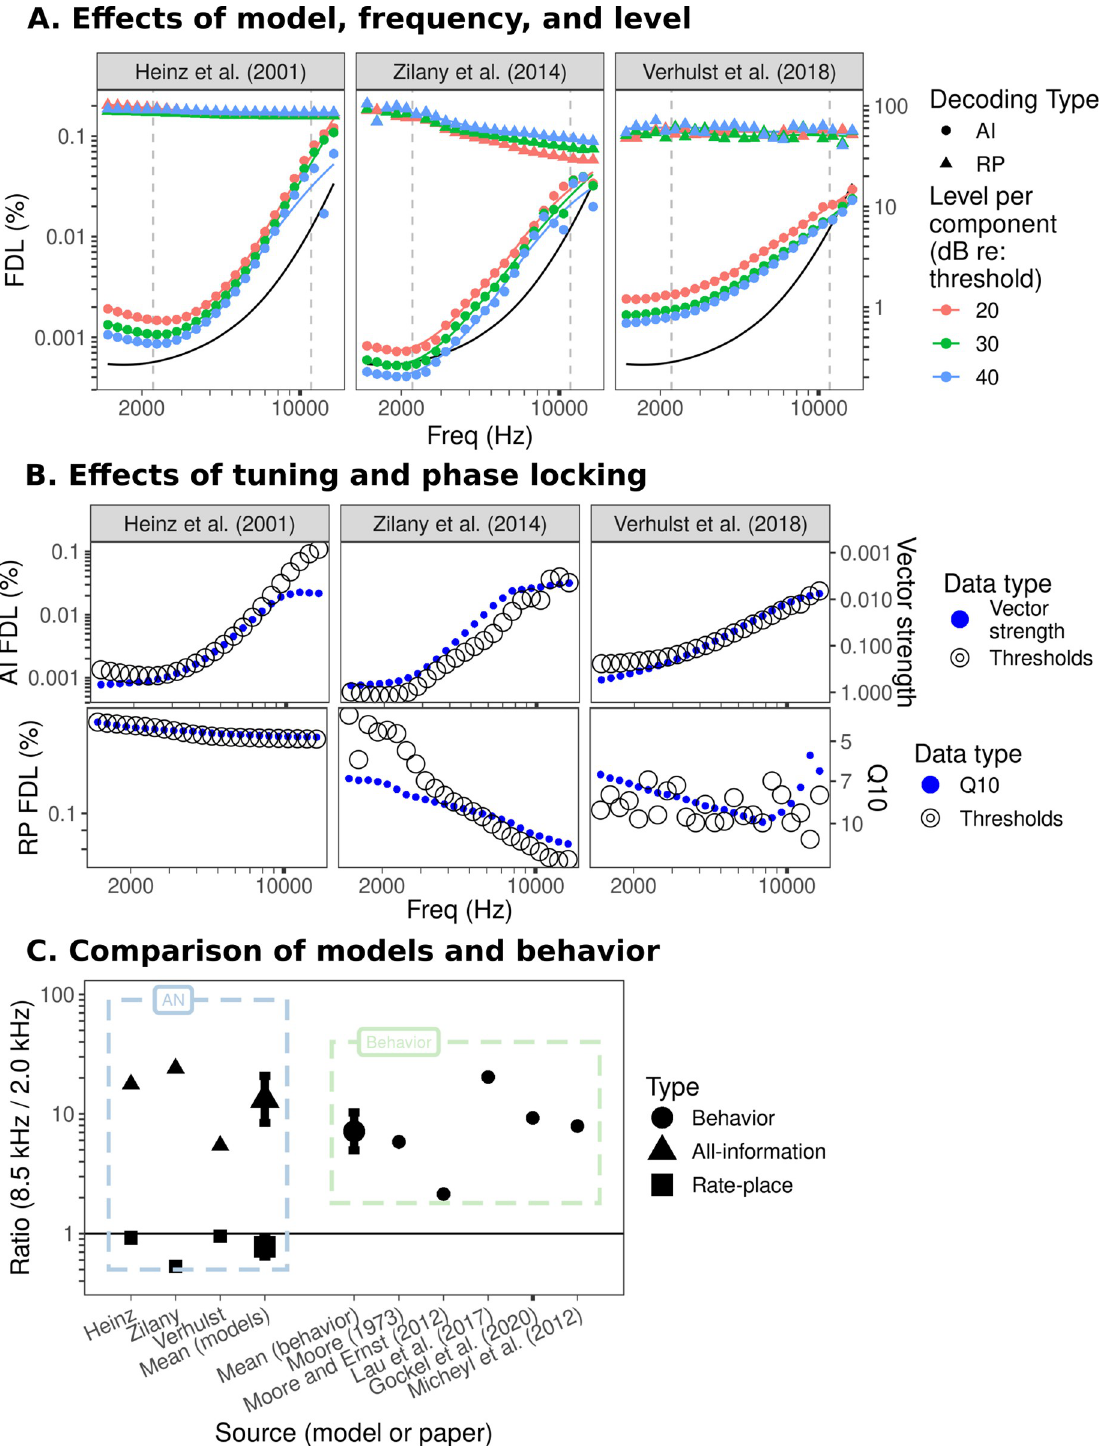
Fig 7. Ideal-observer predictions for pure-tone frequency discrimination. Results of the frequency discrimination simulations. (A) Simulated FDLs versus frequency for a pure tone in each auditory-nerve model. Simulations in this panel include no parameter roving. Points indicate the simulated FDLs at a particular frequency while lines indicate a locally estimated scatterplot smoothing (LOESS) fit to the simulated FDLs. The solid black line indicates the predicted FDLs from Micheyl et al. [58] scaled by a factor of 0.002 (to roughly match the low-frequency side of the curve to the best-performing model predictions from the present study). The axis on the right-hand